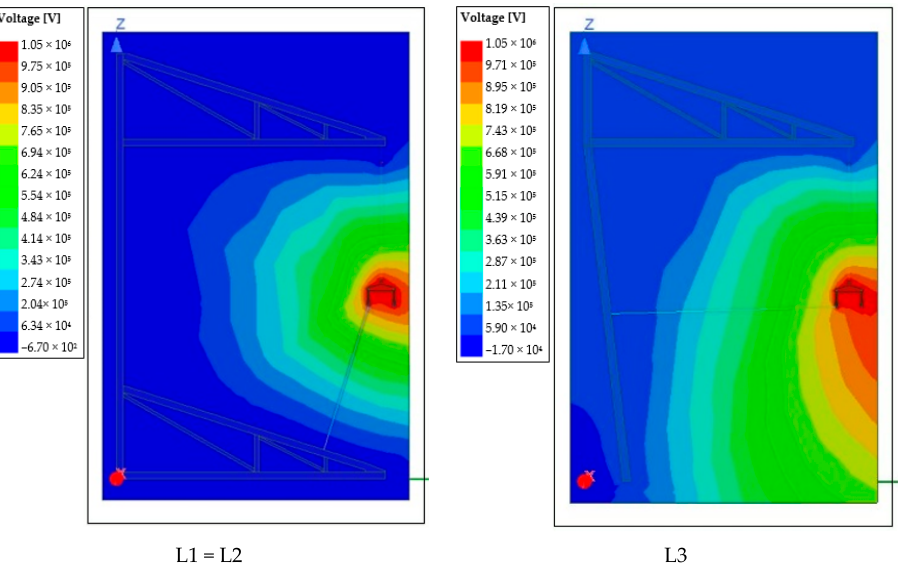
Figure 11. Voltage profile overlay for the L1, L2 and L3 crossarm with a still air condition at BIL under a shielding failure event.